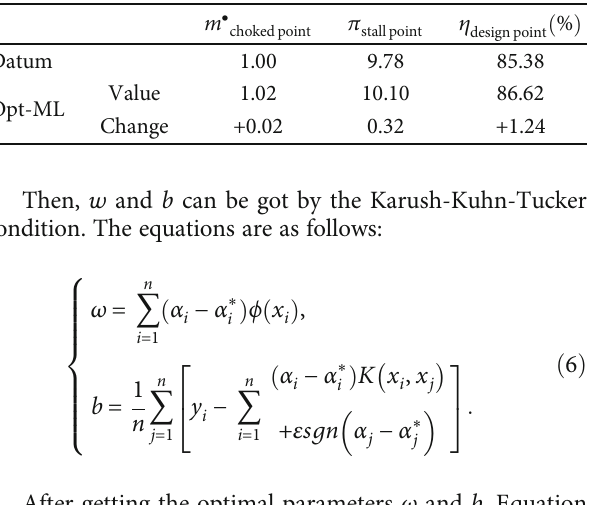
Figure 8: In fl uence on the number of parameters. Table 2: Comparison of